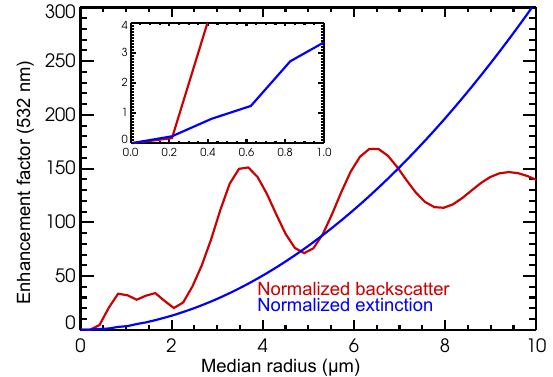
Figure 12. The effect on the backscatter (red line) and extinction (blue line) coefficients at 532nm of a narrow mode (geometric stan- dard deviation 1.1) of large particles (radius varies along x axis) with number concentration 36cm − 3 and complex refractive index 1.57–i0.0037, using the same single scattering Mie modeling as before. The backscatter and extinction coefficients of the modeled coarse mode are in this case much larger than the benchmark values measured by HSRL-2 on 17 July 2012 during the TCAP campaign. The y axis is expressed as the coarse-mode backscatter or extinction divided by the benchmark measurement.